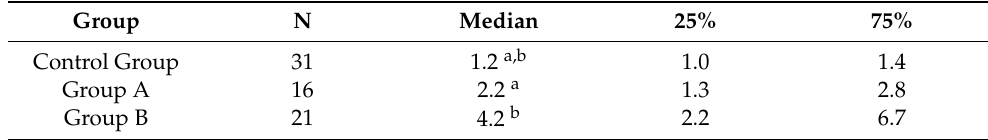
Table 3. Results of lactate levels (mmol/L) in all groups.